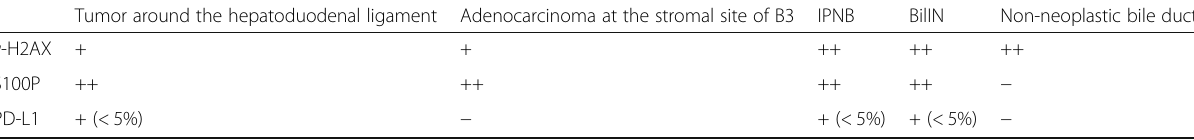
Table 1 Results of immunohistochemical analysis for autopsy specimen Tumor around the hepatoduodenal ligament Adenocarcinoma at the stromal site of B3 IPNB BilIN Non-neoplastic bile duct γ -H2AX